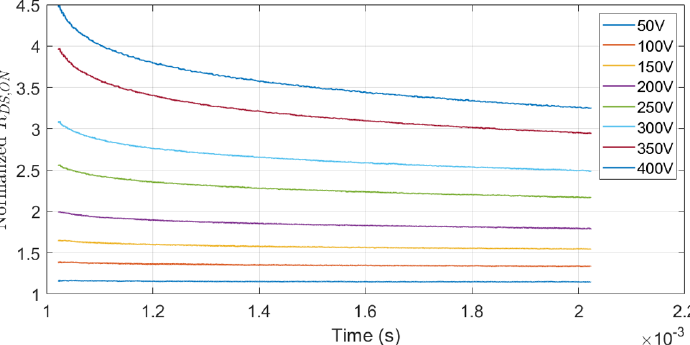
Figure 10. V GS , I DS , and V DS (from isolated voltage probe and Op-Amp) acquired waveforms for R DS , ON calculation at increasing blocking voltage. The displayed time interval starts 5 µ s before the trigger event and ends 20 µ s after the trigger event.